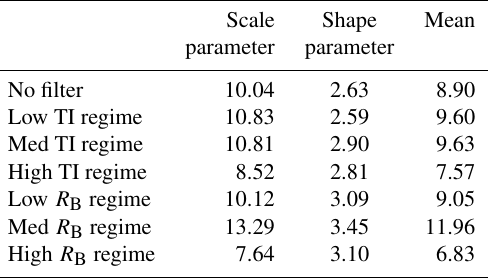
Table 4. Weibull parameters for the case of no stability or turbu- lence filter as well as for each turbulence and stability